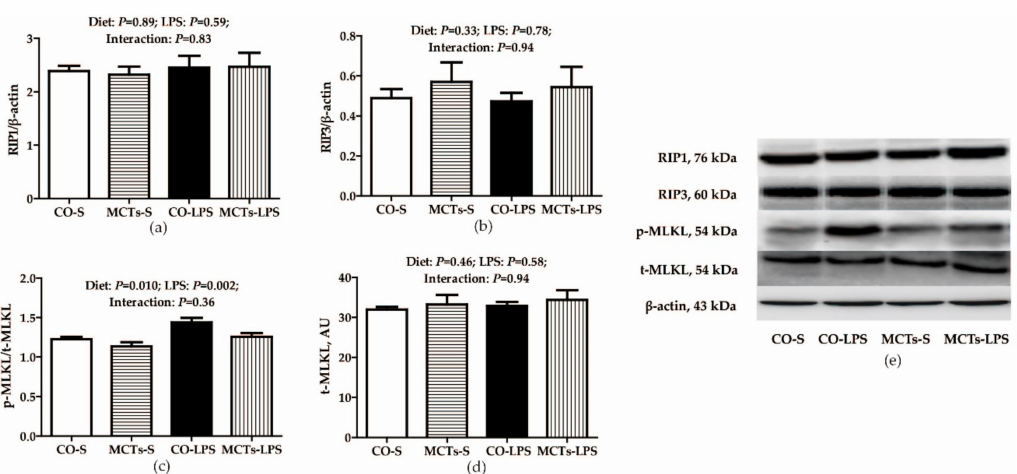
Figure 6. Effect of medium-chain triglyceride (MCT) supplementation on protein expression of key signaling molecules in necroptosis after 4-h LPS challenge in pigs ( a – d ). The bands are the representative Western blot images ( e ). Values are mean and SE, n = 6 (1 pig/pen). All data for protein expression were acquired using Western blot. Values for relative RIP1 and RIP3 expression were normalized against β -actin and the phosphorylated form of MLKL was normalized with total protein content of MLKL. CO-S, pigs fed the control diet and injected with saline; MCTs-S, pigs fed MCTs and injected with saline; CO-LPS, pigs fed the control diet and challenged with LPS; MCTs-LPS, pigs fed MCTs and challenged with LPS. RIP, receptor-interacting serine/threonine-protein kinase; MLKL, mixed-lineage kinase domain-like protein; AU, arbitrary